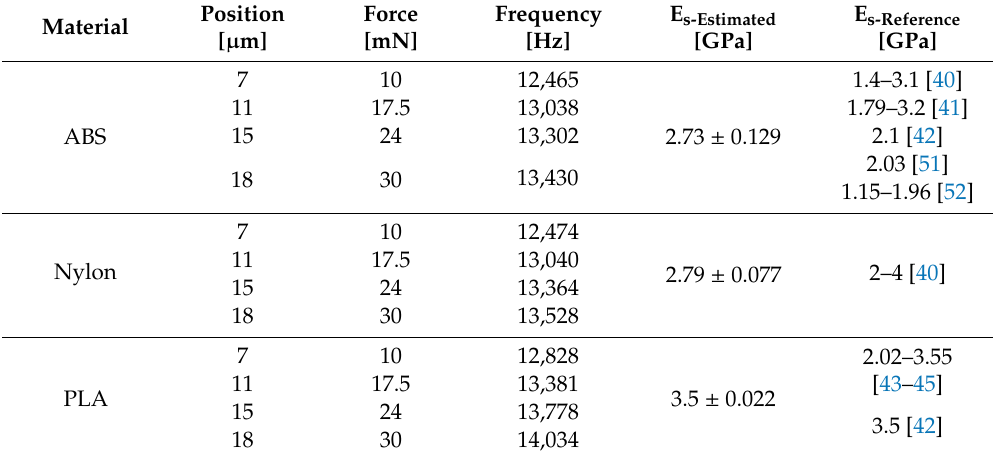
Table4. Materials analysedwith the PZT-2 actuator and their reference valuespublished in the literature.